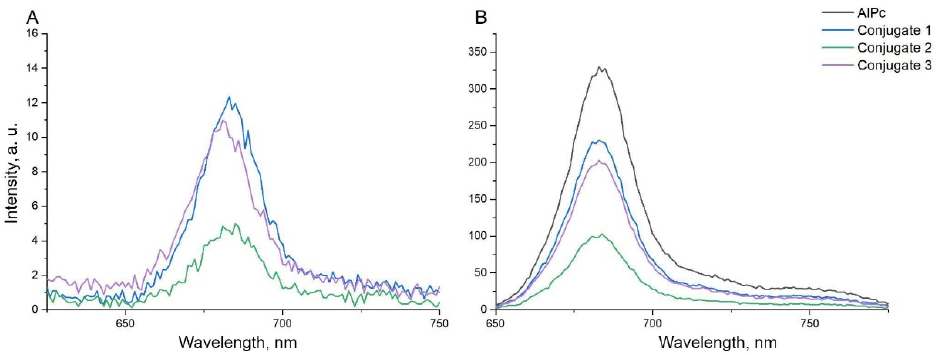
Figure 7. ( a ) Fluorescence spectrum of samples ( λ ex = 485 nm), ( b ) Fluorescence spectrum of samples ( λ ex = 600 nm). The molar concentration of QDs in three conjugates was 33 µ M. The molar concentration of AlPc in conjugate 1 and 3 was 20.4 µ M, in conjugate 2 was 10.2 µ M. The luminescence spectra of conjugates with PS molar concentrations of 20.4 µ M for conjugates 1 and 3, 10.2 µ M for conjugate 2, and free PS with a molar concentration